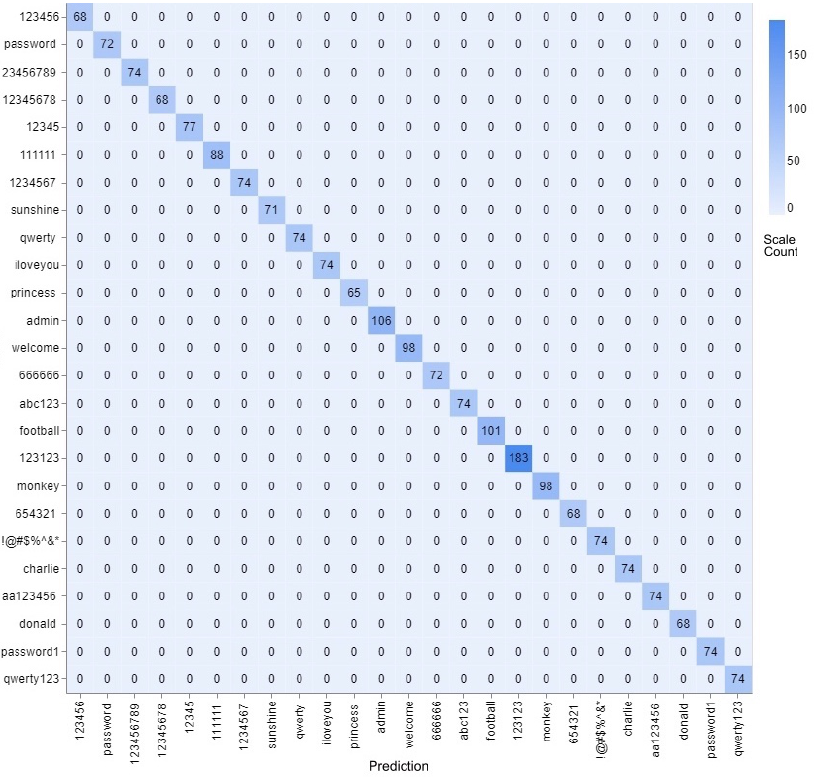
Figure 7. Confusion matrix showing the prediction performance of ThermalAttackNet for 25 most commonly used passwords in 2018